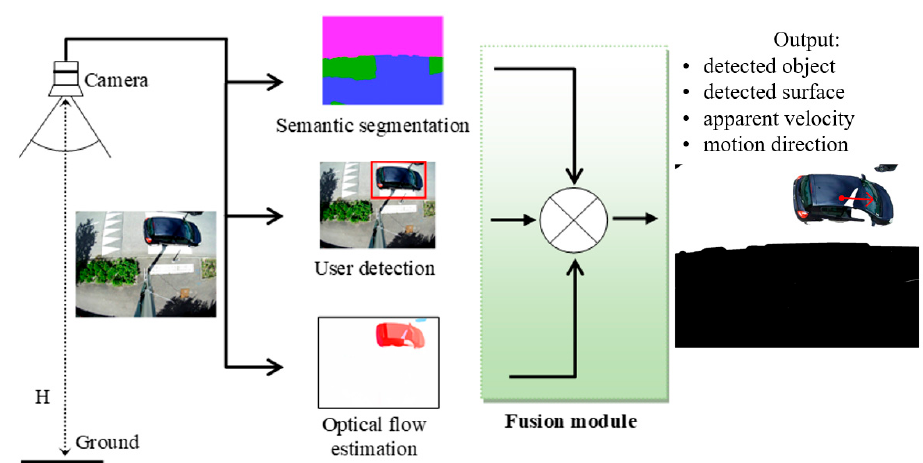
Figure 2. Illustration of the main objectives of the project.